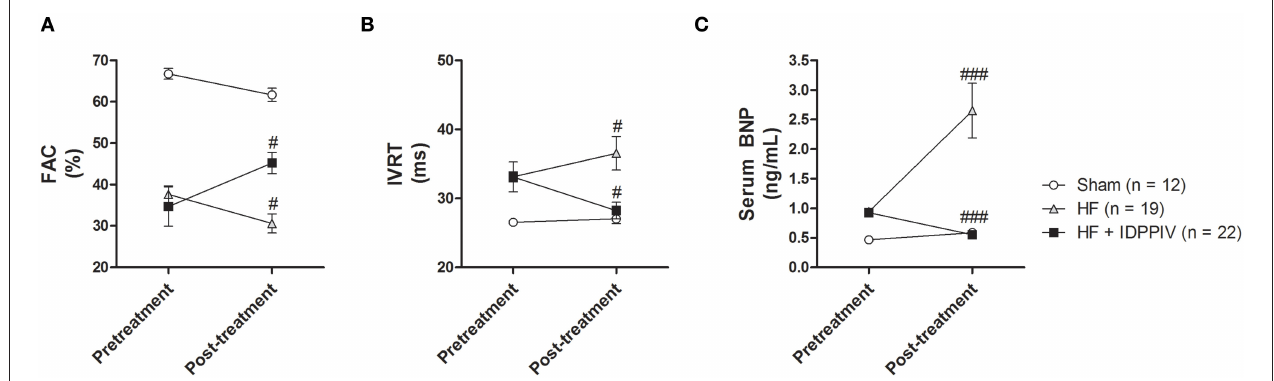
FIGURE 1 | Treatment with vildagliptin improves cardiac function in rats with established HF. Doppler echocardiography and quantitative determination of serum BNP were performed 6 weeks after LV-radiofrequency ablation or sham surgery (pretreatment) and after 4 weeks of treatment with vehicle or vildagliptin (post-treatment). (A) Fractional area change (FAC). (B) Isovolumic relaxation time (IVRT). (C) Serum BNP 32 levels. Values are means ± SEM. # p < 0.05 and ### p < 0.001 vs. pretreatment.